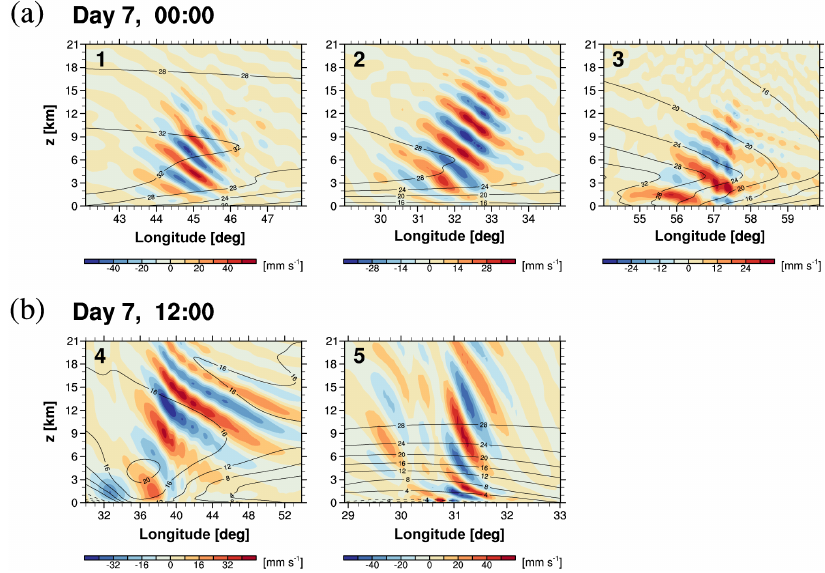
Figure 11. Vertical cross sections of the reconstructed w (cid:48) (shading) along the axes indicated by green lines in Fig. 5. The background wind projected onto the propagation direction of each wave is also plotted (contour). w (cid:48) is multiplied by exp ( − z/ 2 H) , where H =